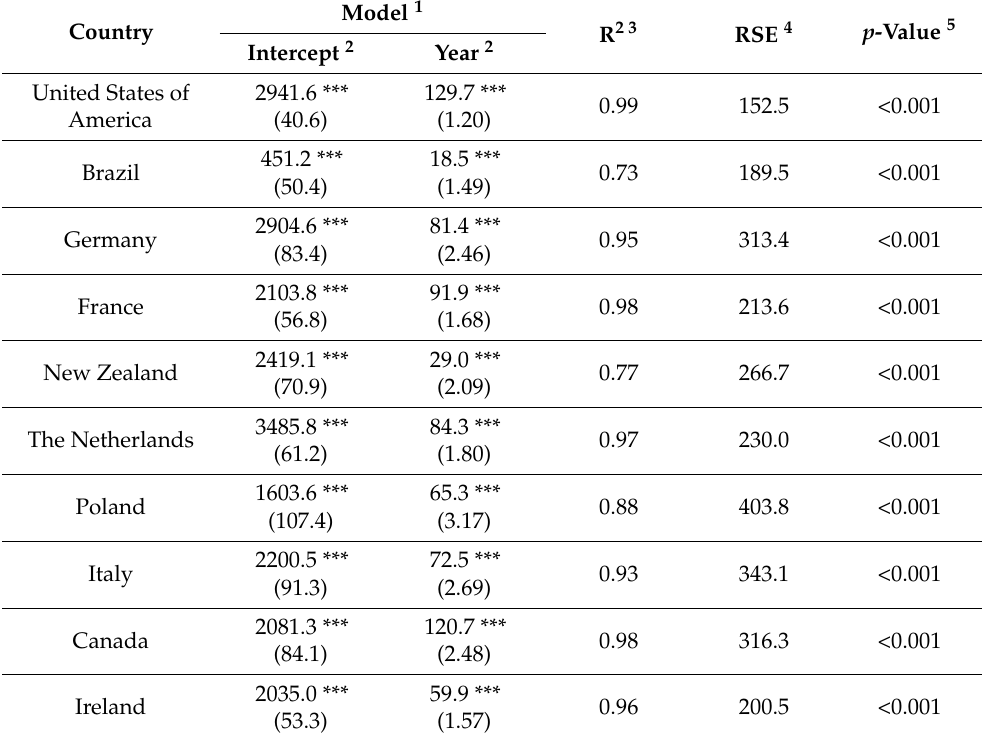
Table 2. The linear trend of milk yield (kg) per animal per year for each country between 1961 and 2018. The list of countries is limited to the world’s top high milk-producing countries for which we were able to provide sufficient and reliable data on the length of productive